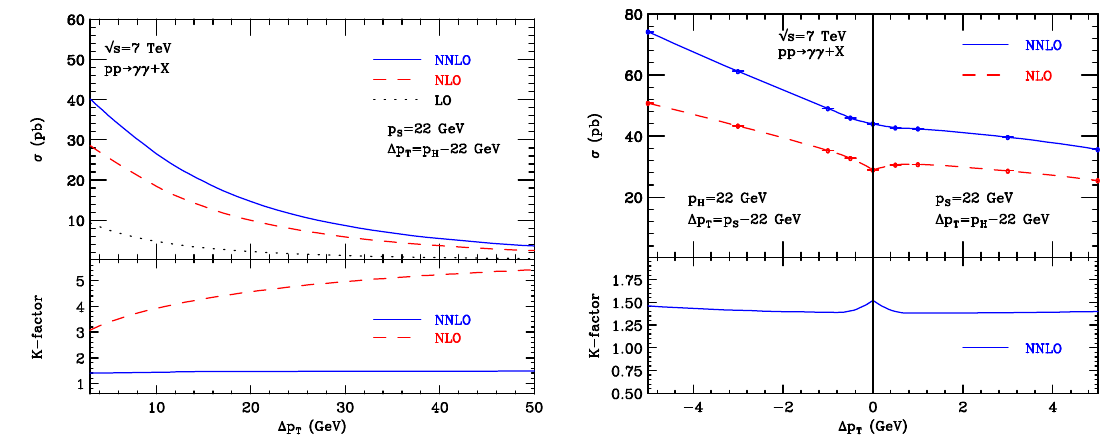
Figure 19 . Dependence on the photon p T cuts p H and p S ( p hard section for diphoton production (the other kinematical cuts are the same as in table 2). The NLO (red dashed) and NNLO (blue solid) results are separately presented in the regions of asymmetric (left panel) and nearly-symmetric (right panel) p T cuts. The LO result (black dotted) is presented only in the case of asymmetric p T cuts (left panel). The lower subpanels present the corresponding NLO (red dashed) and NNLO (blue solid) K